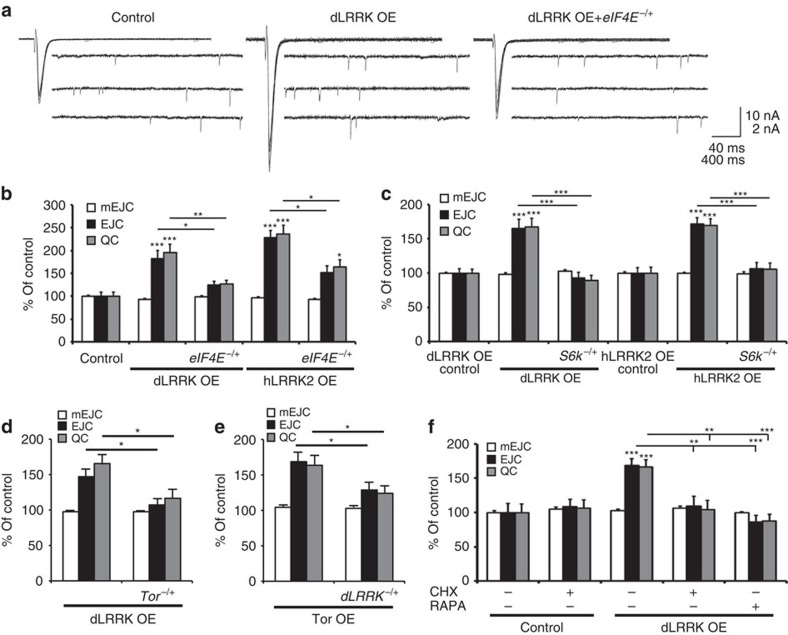
Retrograde synaptic enhancement by dLRRK and hLRRK2 is dependent on translation.(a) Representative traces of mEJCs and EJC from control (G14-Gal4/+), dLRRK muscle overexpression (G14-Gal4/UAS-dLRRK) and dLRRK muscle overexpression in eIF4E heterozygotes (G14-Gal4/UAS-dLRRK; eIF4Es058911/+). (b) Quantification of mEJC, EJC and QC from the genotypes shown in a, as well as hLRRK2 overexpression in the muscle (+/G14-Gal4; UAS-hLRRK2/+) and hLRRK2 muscle overexpression in eIF4E heterozygotes (+/G14-Gal4; UAS-hLRRK2/eIF4Es058911). n=13, 18, 16, 10 and 10. (c) Quantification of mEJC, EJC and QC from control larvae for dLRRK (UAS-dLRRK/+), larvae overexpressing dLRRK in muscle (G14-Gal4/UAS-dLRRK), dLRRK muscle overexpression in S6k heterozygotes (UAS-dLRRK/G14-Gal4; +/S6kl−1), control larvae for hLRRK2 (UAS-hLRRK2/+), hLRRK2 overexpression in muscle (G14-Gal4/+; +/UAS-hLRRK2) and hLRRK2 muscle overexpression in S6k heterozygotes (+/G14-Gal4; UAS-hLRRK2/ S6k1−1). n=21, 20, 20, 20, 28 and 20. (d) Quantification of mEJC, EJC and QC from larvae overexpressing dLRRK in muscle (MHC-Gal4/UAS-dLRRK) or in combination with Tor heterozygocity (UAS-dLRRK/MHC-Gal4; +/Tor). n=14 and 19. (e) Quantification of mEJC, EJC and QC from larvae overexpressing TOR in muscle (MHC-Gal4/UAS-TOR) or in combination with dLrrk heterozygocity (UAS-TOR/MHC-Gal4; +/dLrrke03680). n=16 and 19. (f) Quantification of mEJC, EJC and QC from control larvae (MHC-Gal4/+) and larvae overexpressing dLRRK in muscle (+/UAS-dLRRK; MHC-Gal4/+) grown on normal food or food supplemented with 500 mg ml−1 cycloheximide or 1 μM rapamycin for 12 h. n=10, 10, 10, 8 and 8. Error bars represent s.e.m. *P<0.05, **P<0.01 and ***P<0.001. See also Supplementary Table 1.